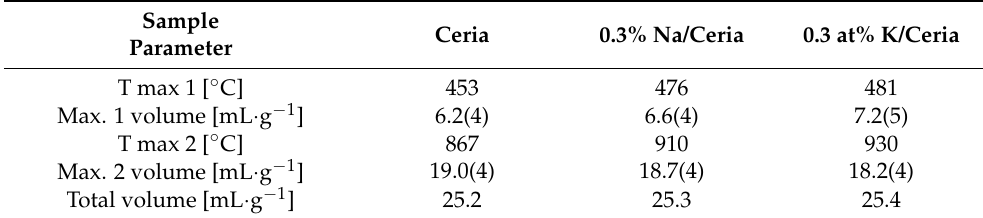
Table 2. TPR results: reduction temperatures and volumes determined for the precipitated ceria doped with potassium and sodium ions. The error of determination is written in brackets after the number.